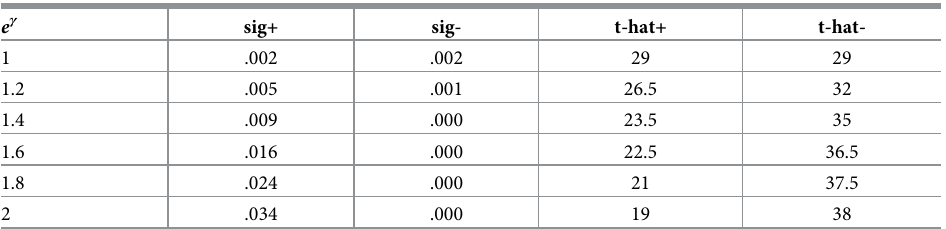
Table 3. Impact of ComFishIII on biodiversity: Rosenbaum